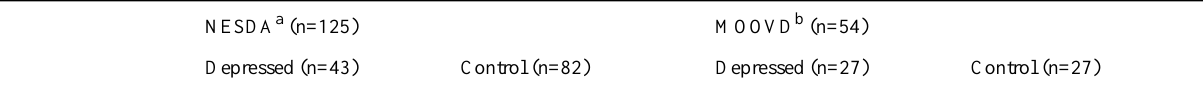
Table 1. Characteristics of development and validation data